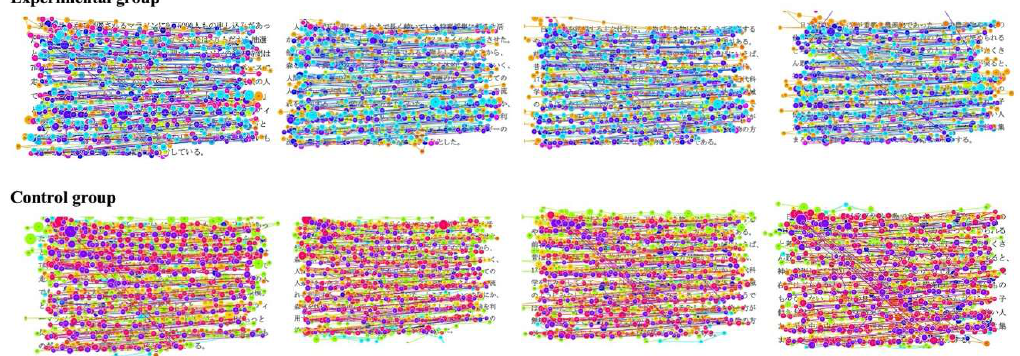
Figure 9. Fixation trajectory map of the two groups in four Japanese reading articles.